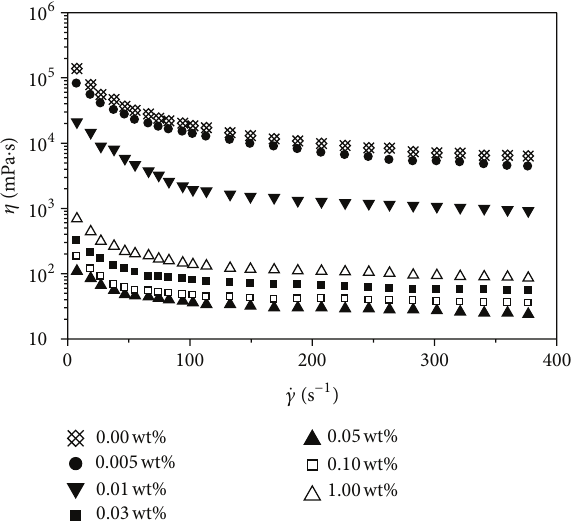
Figure 2: Apparent viscosity ( 𝜂 ) versus shear rate ( ̇𝛾 ) flow curves for the 77.5 wt% alumina + sodium polyphosphate suspensions studied.